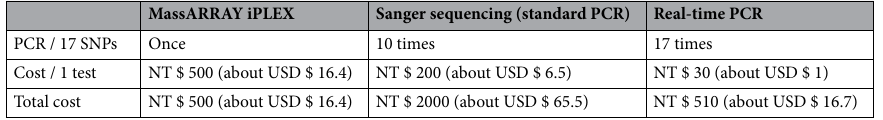
Table 3. Comparison of different methods for detecting these 17